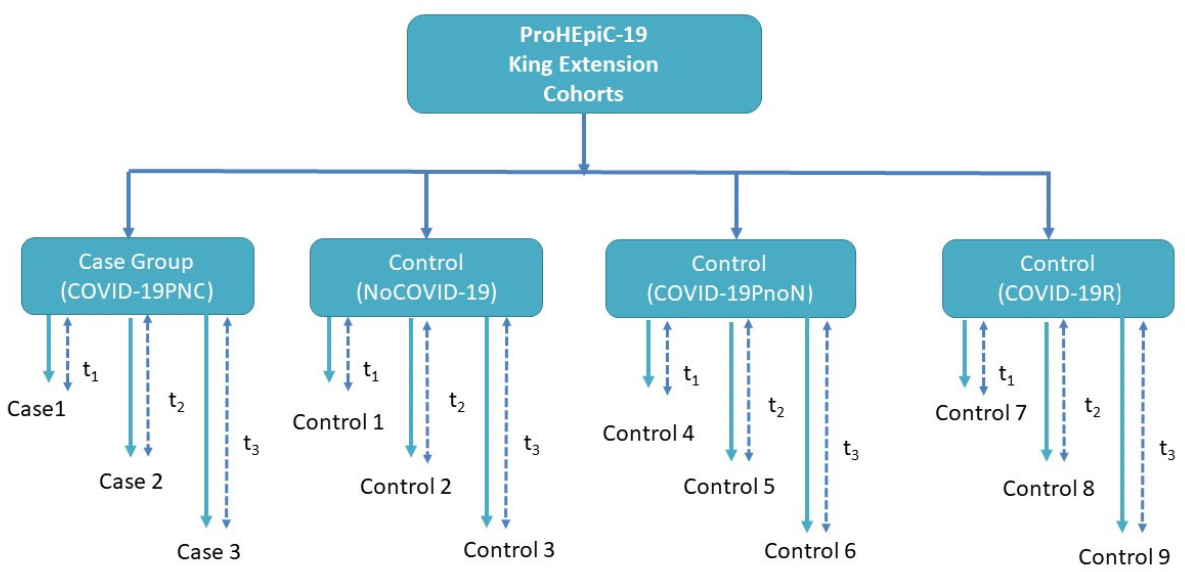
Figure 1. Nested case–control study in a cohort study. Persistent neurocognitive deficits in PCC (COVID19-19PNC) patients. The three control groups include PCC patients with no neurocognitive deficits (COVID-19PnoN), patients who had recovered from COVID-19 (COVID-19R), and healthy controls who did not have COVID-19 (NoCOVID-19).